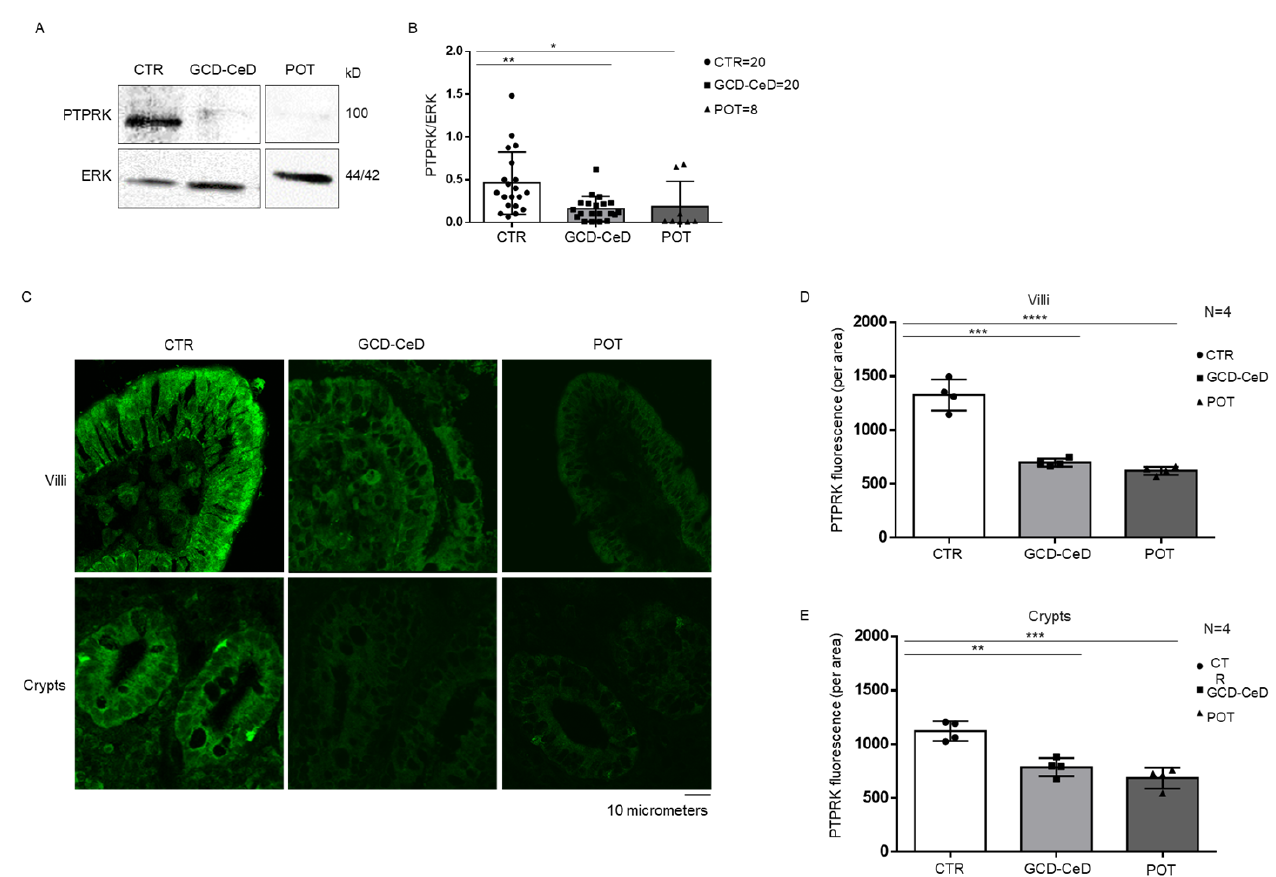
Figure 1. PTPRK protein is decreased in intestinal enterocytes from CeD biopsies ( A ). Western blot analysis of total protein lysates of intestinal biopsies from controls (CTR), CeD patients in the acute phase of the disease (GCD–CeD) and CeD potential patients (Pot–CeD). Upper lines were blotted with an antibody against PTPRK. Anti-ERK (extracellular-signal-regulated kinase) anti- body was used as loading control (bottom lines). Representative images are shown. ( B ). Densito- metric analysis of the PTPRK/ERK bands from CTR, GCD–CeD and Pot–CeD.Number of patients analysed are indicated (N = 5). Columns represent the mean and bars the standard deviation. Stu- dent ' s t test: * = p < 0.05; ** = p < 0.01. ( C ). Immunofluorescence images of intestinal biopsies crypts and villi from CTR, GCD–CeD and Pot–CeD stained with anti-PTPRK antibodies. ( D , E ). Statistical analysis of PTPRK immunofluorescent staining in villi and crypts from CTR, GCD–CeD and Pot–CeD. Columns represent the mean and bars the standard deviation. Student ’ s t test: * p < 0.05; **= p < 0.01; *** = p < 0.001; **** = p < 0.0001. N represent number of organoids evaluated.